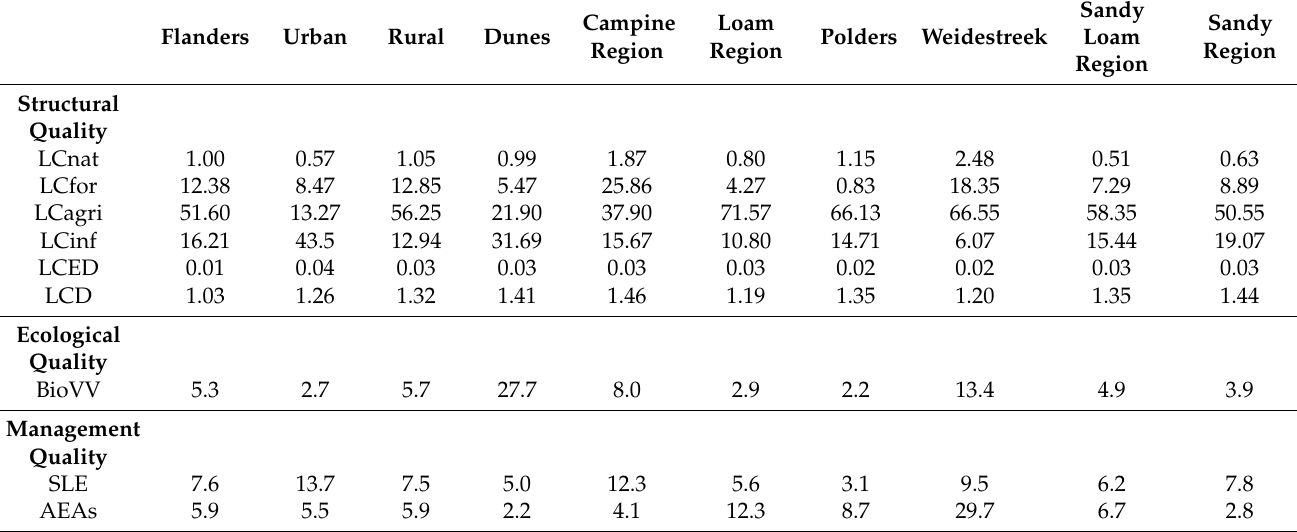
Table 3. Structural quality indicators (data applies to 2012 and was extracted from [22]), ecological quality indicators and management quality indicators for Flanders, urban and rural areas, and the seven agricultural regions. (see Table 1 for description of